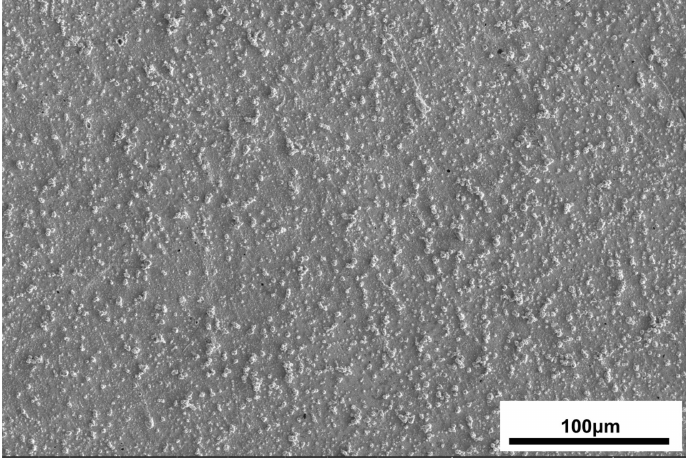
Figure 5. SEM image of copper-coated carbon fiber-reinforced polymer (CFRP) for 60